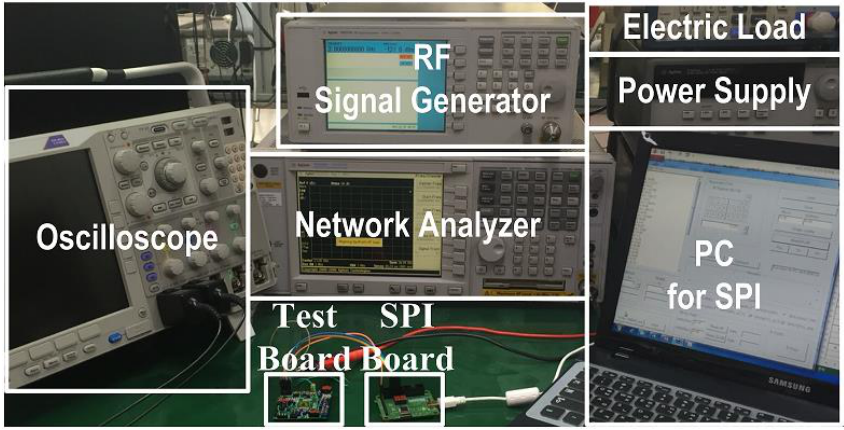
Figure 18. Measurement setup for the SWIPT IC.